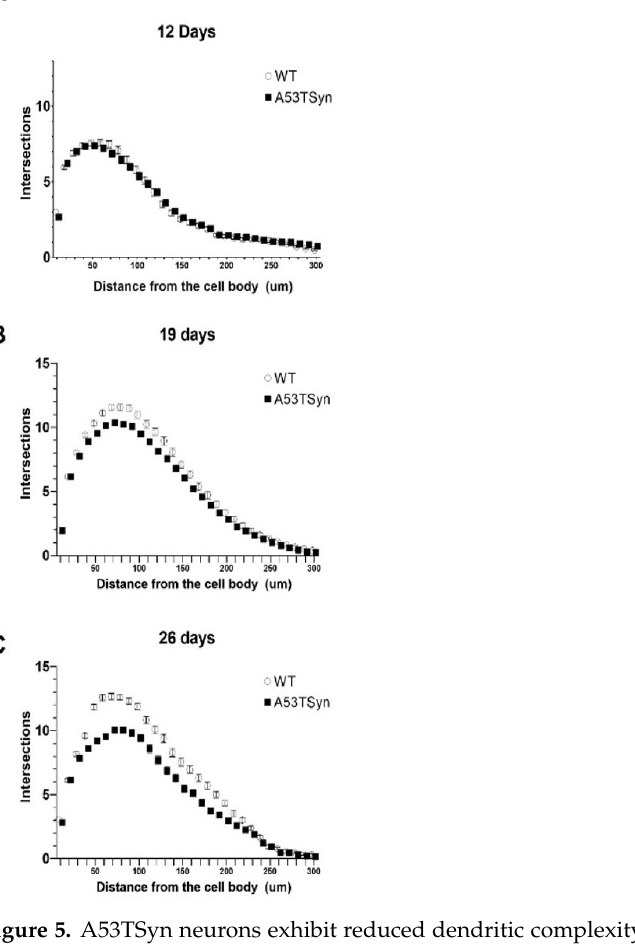
Figure 5. A53TSyn neurons exhibit reduced dendritic complexity with longer culture time. After 12 DIV no genotype differences in arborization were observed between A53TSyn and WT hippocam- pal neurons ( A ). At 19DIV reduced arborization began to emerge in A53TSyn neurons ( B ) and this reduction is even more pronounced 26DIV ( C ).